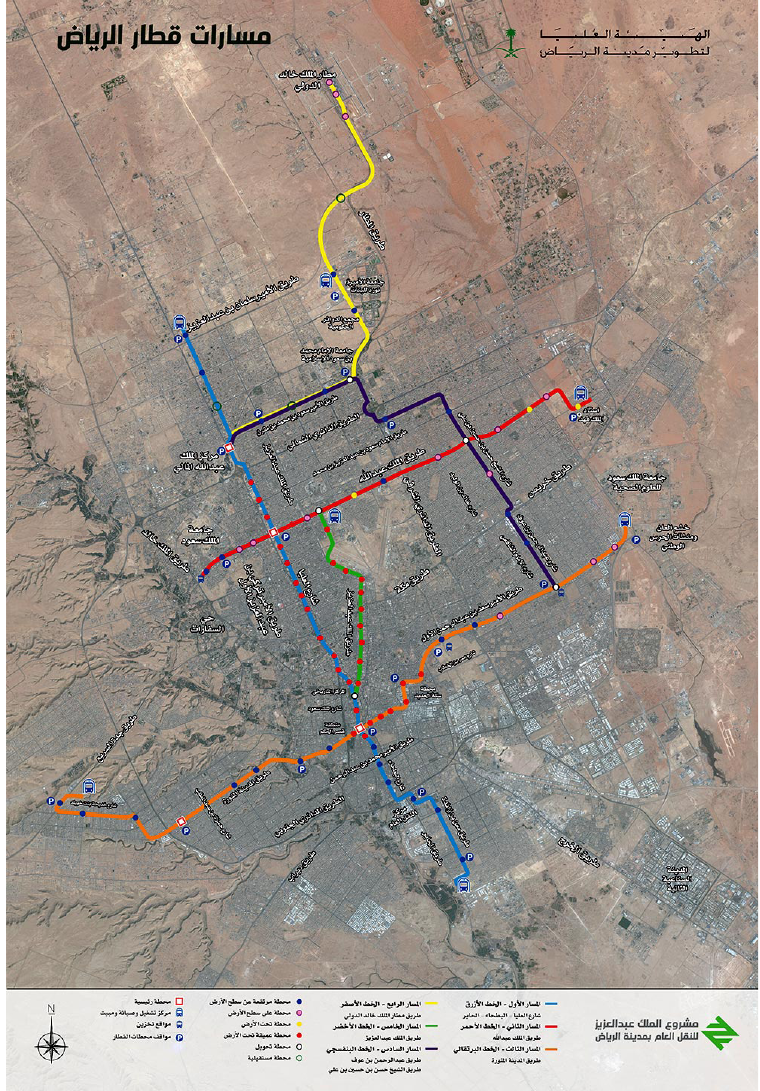
Figure 4. The Riyadh Metro map consists of six main lines with 176 km in length and 85 stations in total. Source: Royal Commission for Riyadh City (n.d.).